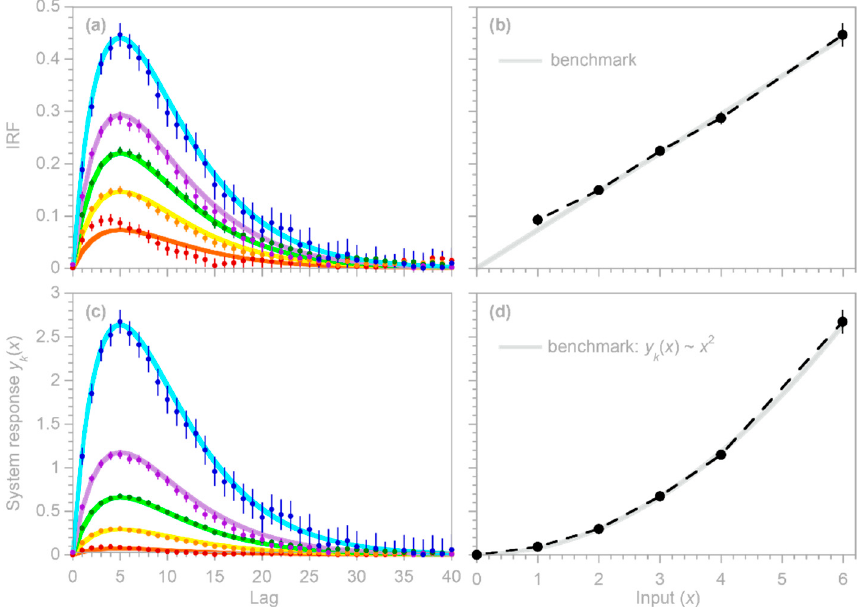
Figure 10. Benchmark test of nonlinear deconvolution. Benchmarks (lines) and estimated impulse responses (dots) are shown for a benchmark test in which the impulse response function ( a , b ) is proportional to the input, and thus the system’s response—the impulse response function times the input ( c , d )—is a quadratic function of the input. The impulse response functions (system response per unit input) and the system responses themselves, along with their benchmarks ( a , c ), are evalu ‐ ated at the knots 𝜅 ℓ (in this case, at values of 1, 2, 3, 4, and 6, the highest value of the input 𝑥 ). The benchmarks are shown by the colored lines in panels ( a ) and ( c ), with the impulse response func ‐ tions shown by the corresponding colored symbols. The corresponding peak values of the impulse response function and system response are shown in panels ( b ) and ( d ), with the benchmark rela ‐ tionships shown by gray lines. Error bars show 1 standard error, wherever this is larger than the plotting symbols. The input time series 𝑥 and the noise ‐ corrupted output time series 𝑦 , along with a set of knots 𝜅 , are supplied to the 𝑛𝑜𝑛𝑙𝑖𝑛𝐼𝑅𝐹 routine, which applies the approach out ‐ lined in Equations (42)–(47) above and calls the 𝐼𝑅𝐹 routine to perform the core calcula ‐ tions. Note that these algorithms are not provided with any information about the bench ‐ mark impulse responses or their nonlinear dependence on 𝑥 , beyond what is contained in the time series themselves, where the effects of the individual inputs are overprinted on one another. Figure 10 shows example results for a simple case in which the amplitude of the im ‐ pulse response function scales proportionally to the input 𝑥 (Figure 10a,b) and thus the system response 𝑦 (cid:3038) (cid:4666)𝑥(cid:4667) scales proportionally to 𝑥 (cid:2870) (Figure 10c,d). The estimated impulse response functions and system responses 𝑦 (cid:3038) (cid:4666)𝑥(cid:4667) (dots) generally agree with the bench ‐ marks (lines, evaluated at the knots 𝑥 (cid:3404) 𝜅 ℓ ), with the exception of the weakest responses (red dots, corresponding to the smallest values of 𝑥 ), which often deviate from their benchmarks by more than their standard errors. The weak signals from these small inputs are swamped by the much larger noise (Figure 9b,c), and distorted by coincidental corre ‐ lations with the much stronger signals from much larger inputs. These deviations are much less visible in plots of the system response 𝑦 (cid:3038) (cid:4666)𝑥(cid:4667) , almost vanishing into the 𝑥 axis (e.g., Figure 10c); they are only evident in plots of the impulse response function IRF (cid:3404) 𝛽 (cid:3038) (cid:4666)𝑥(cid:4667) (cid:3404) 𝑦 (cid:3038) (cid:4666)𝑥(cid:4667)/𝑥 (e.g., Figure 10a). Thus, although the impulse response per unit input (the IRF) can exhibit substantial deviations when both the input and the resulting impulse response are small (because the system output 𝑦 is relatively insensitive to small values of 𝑥 ), for the same reason, these deviations will have only a minimal effect on the overall system behavior. By contrast, the stronger signals that correspond to higher input values